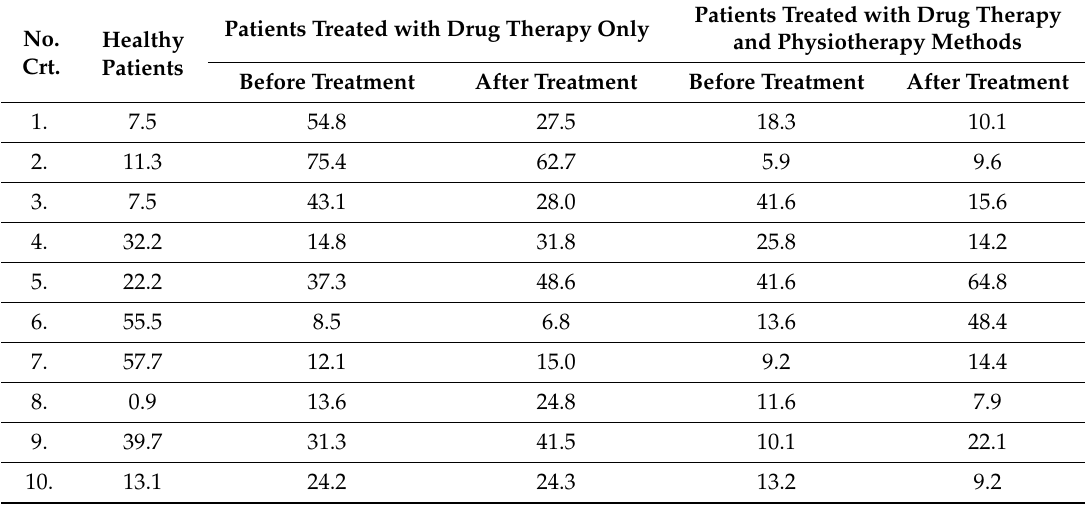
Table 4. Serum cortisol levels before and after treatments / dog groups given as ng × mL − 1 . No. Healthy Crt. No. Crt.